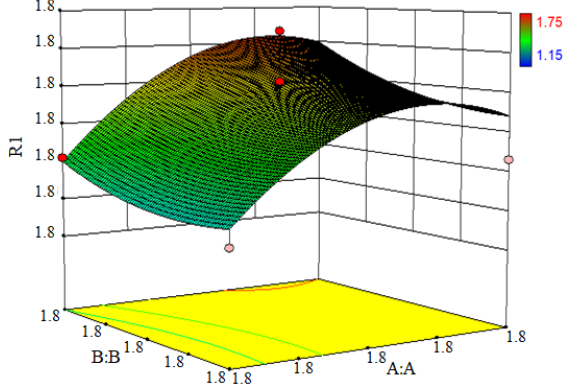
Figure 8. A 3D map of the response surface.